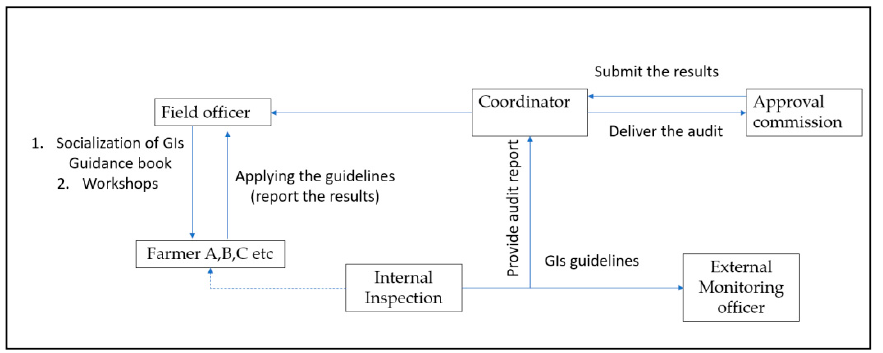
Figure 8. Internal control system adopted from GIs handbook of requirements. Source: TAKTIK [consent for publication].